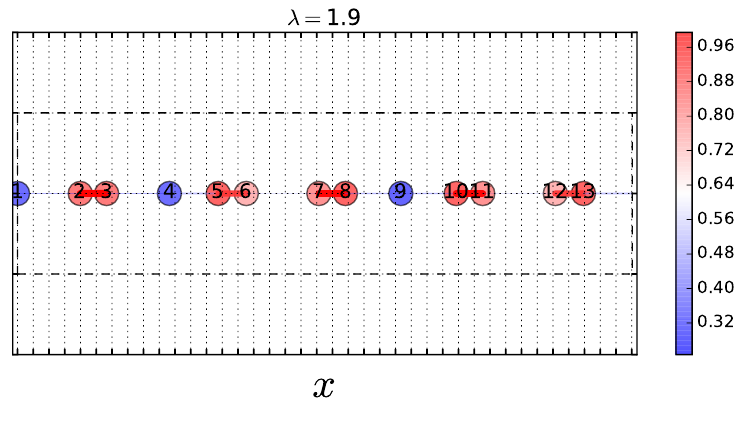
Figure 16: Ground state configuration for a chain of period N = 13 filled with 5 pairs of electrons ( c = 5 ), in the nonintegrable case ( λ = 1.9) and low enough pressure 13 (here p = 0.006) to be below the Aubry transition: the CDW form local dimers (five strong covalent bonds with the five pairs of electrons). The scale on the right is the electronic